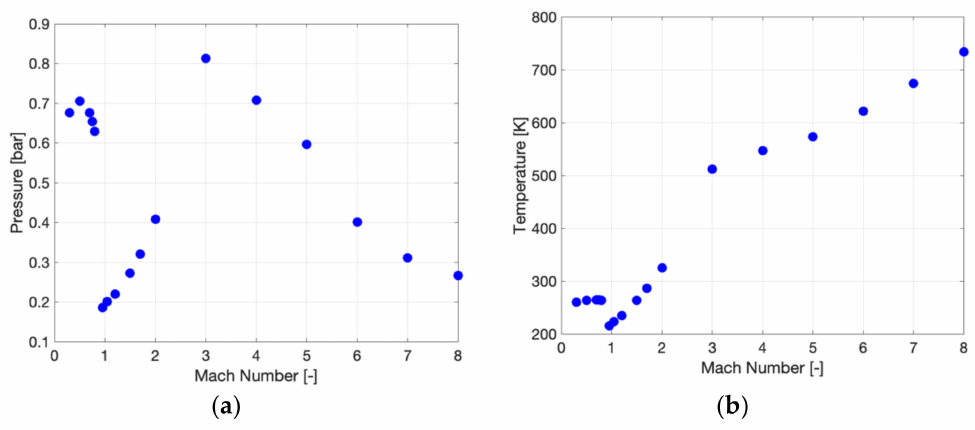
Figure 5. ( a ) Pressure versus Mach of ram-air; ( b ) temperature versus Mach of the